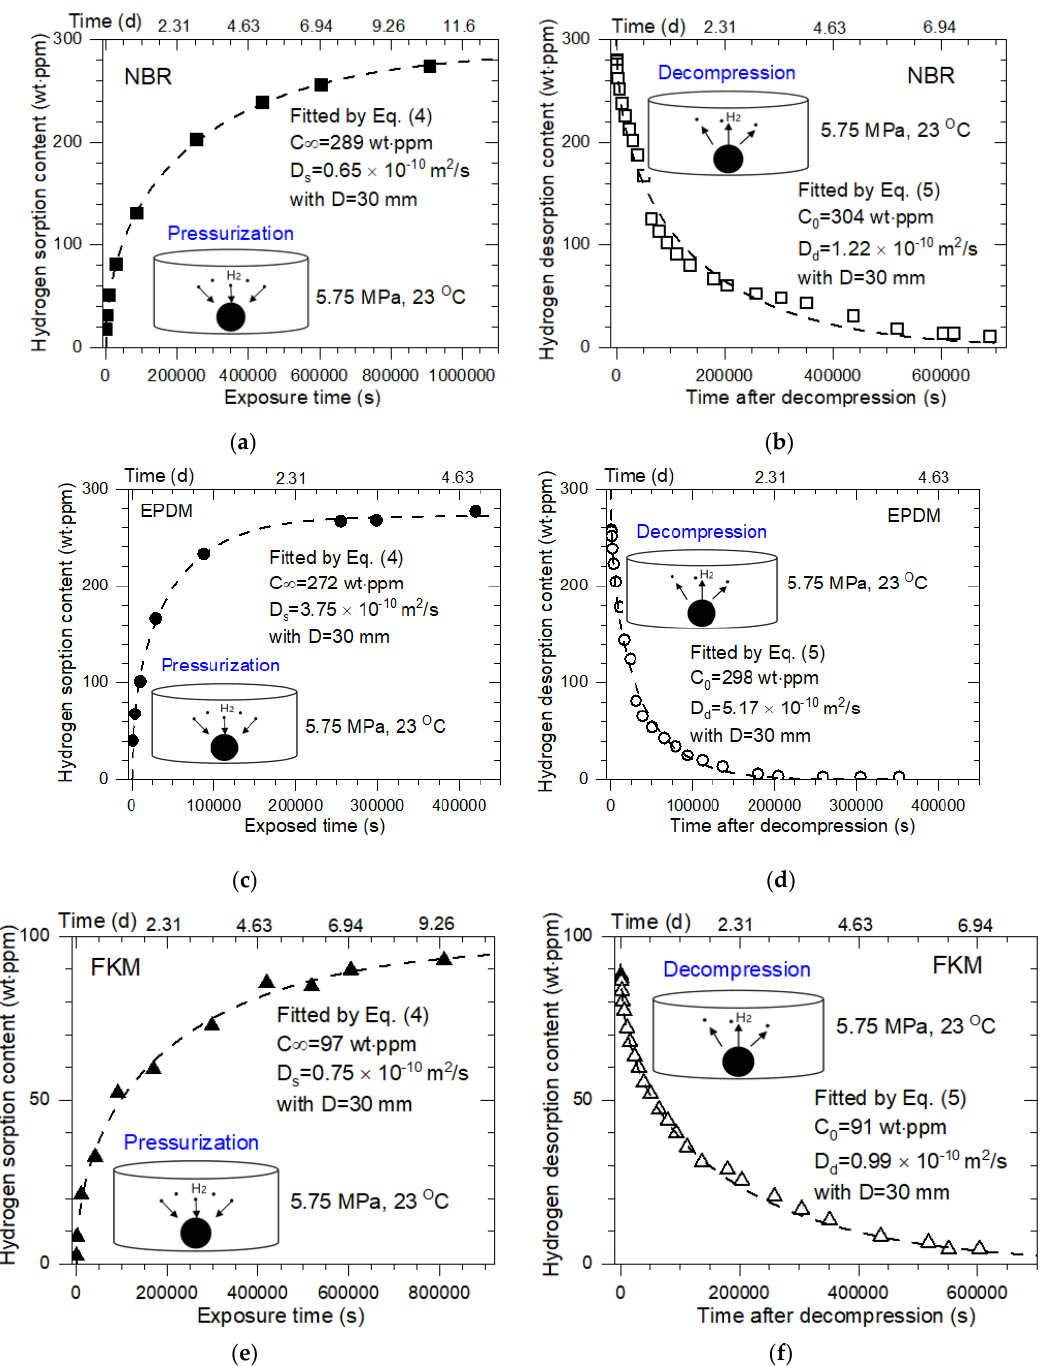
Figure 3. ( a ) H 2 sorption content versus exposure time and ( b ) H 2 desorption content versus time after decompression of spherical-shaped NBR samples with diameters of 30 mm. Filled square: sorp- tion data; open square: desorption data; dashed lines: fitted result from Equations (4) and (5). ( c ) H 2 sorption content and ( d ) H 2 desorption content for spherically shaped EPDM samples with diame- ters of 30 mm. Filled circle: sorption data; open circle: desorption data; dashed lines: fitted result from Equations (4) and (5). ( e ) H 2 sorption content and ( f ) H 2 desorption content for spherically shaped FKM samples with diameters of 30 mm. Filled triangle: sorption data; open triangle: desorp- tion data; dashed lines: fitted result from Equations (4) and (5). Table 2. H 2 content and diffusivity for the sorption (desorption) process for spherically shaped NBR, EPDM, and FKM at 5.75 MPa and 296 K. Specimen